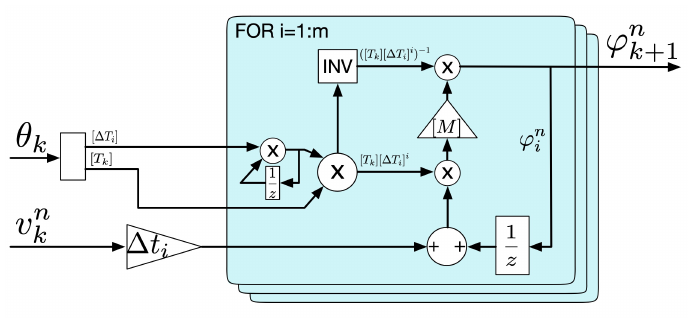
Figure 6. Discrete time model with fast matrix inversion: INV-DSCR.